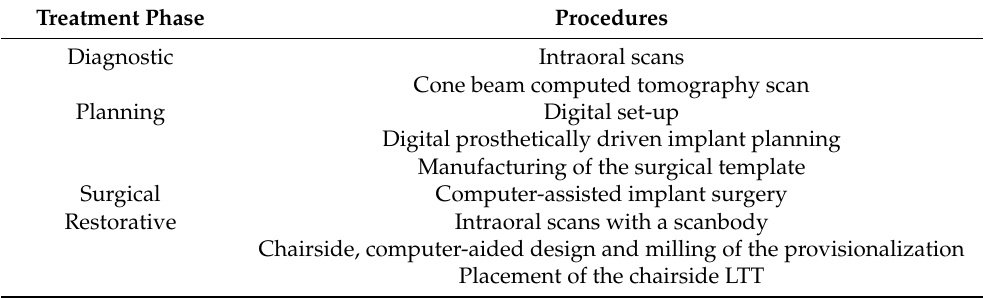
Table 2. Timeline of the diagnosis, planning, implant placement, and chairside provisionalization. Treatment